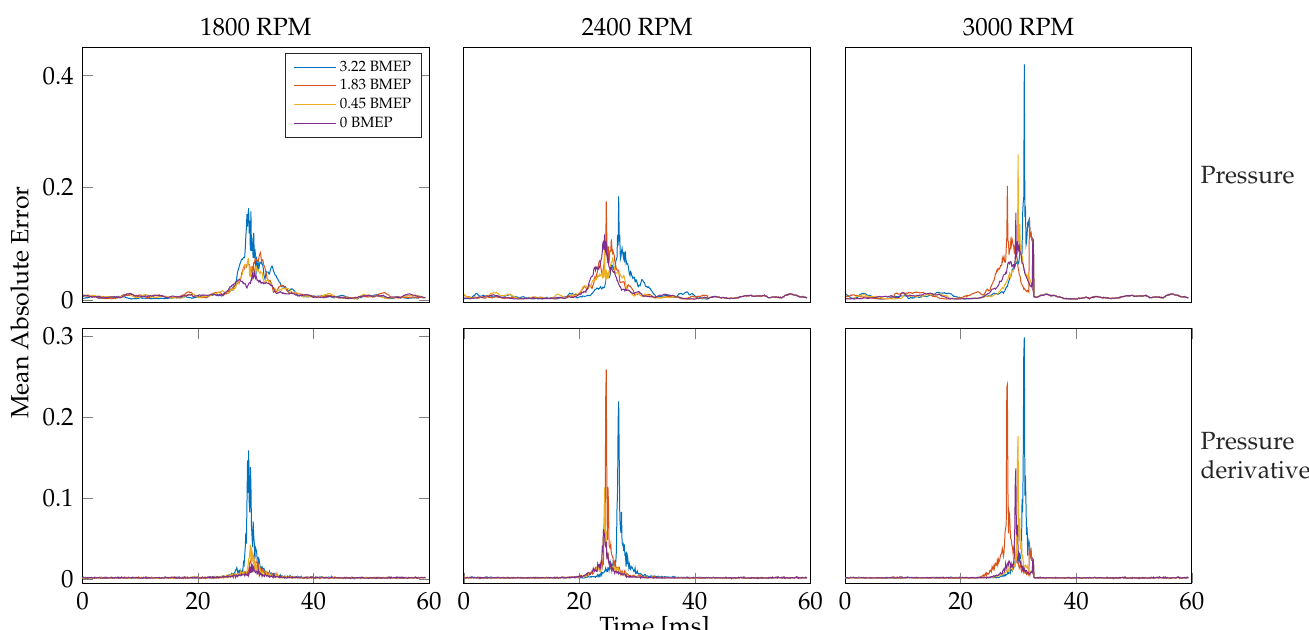
Figure 12. TDNN–based pressure and pressure derivative prediction results. The mean absolute error is shown for the 12 considered states by varying the engine speed and load. First row: pressure estimation results. Second row: pressure derivative estimation results. The columns stand for the studied velocities (RPM) and the line colors for the loads